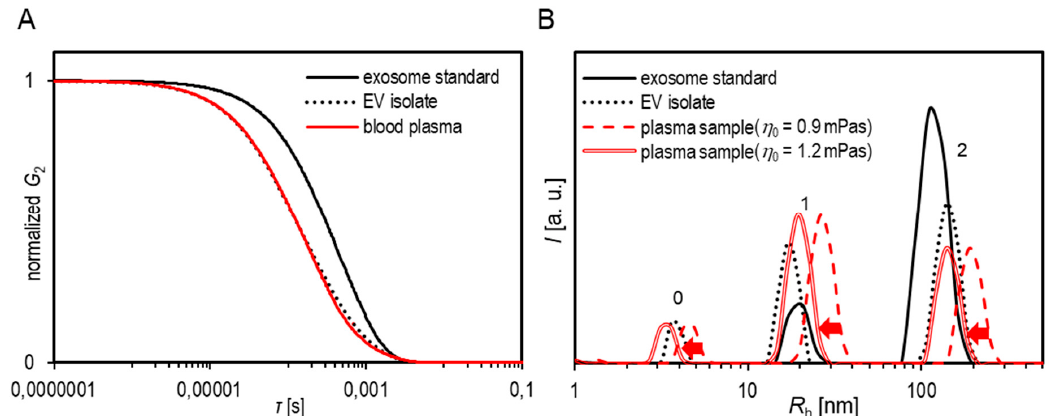
Figure 2. ( A ) The measured correlation functions G 2 ( t ) and ( B ) the calculated size distributions of particles in an unfiltered exosome standard (solid black line), a fresh plasma sample (dashed red line) and the corresponding EV isolate from the same sample (dotted black line). In calculation of R h (Equation 2) for the exosome standard, the viscosity coefficient of water ( η 0 = 0.9 mPa/s ) was used, while for the plasma sample both, water (dashed red line) and the estimated viscosity of the plasma medium ( η = 1.2 mPa·s; double red line; for details see text below) were taken into account. The arrows depict the shift of peak positions in the plasma sample after the viscosity correction .